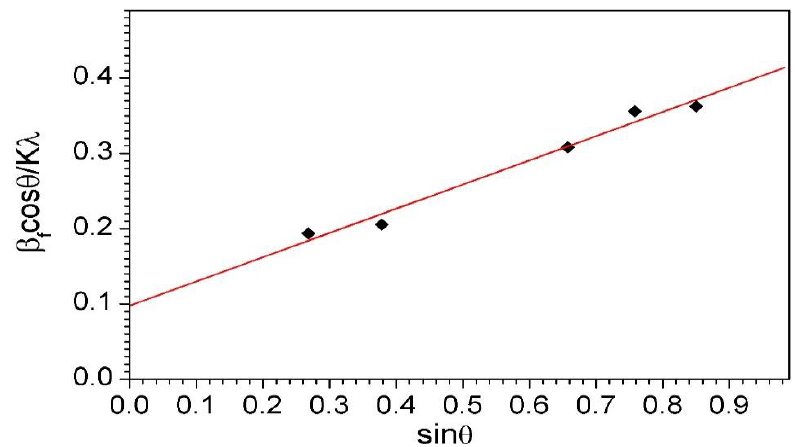
Figure 6. Williamson–Hall plot for the NiAl phase in the final milling product.